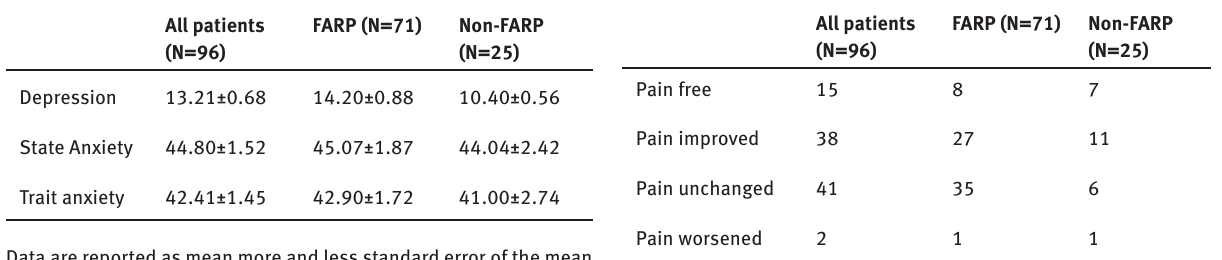
Table 7: Results of the follow-up All